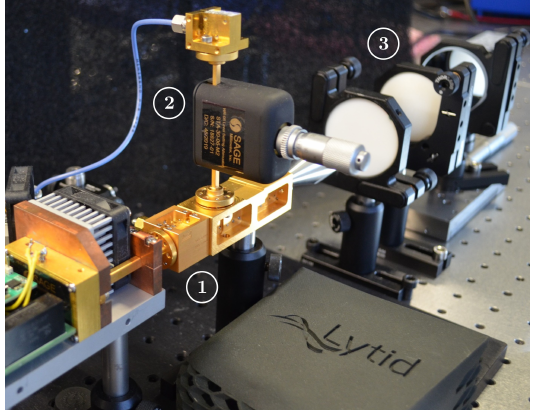
Figure 2. Picture of the FMCW radar transceiver in development. (1) HF multiplication chain, (2) homodyne detection branch, and (3)